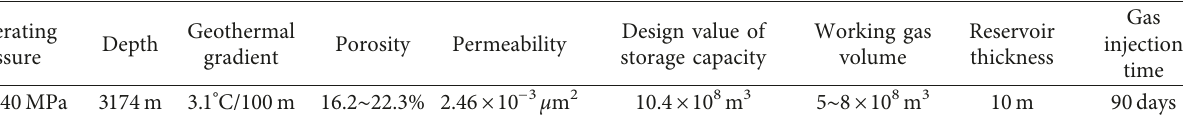
Table 2: Design parameters of gas storage.